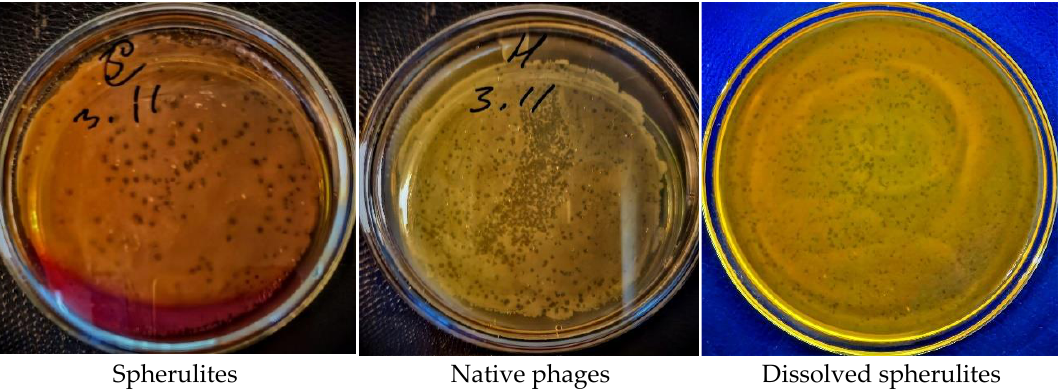
Figure 9. Influence of bacteriophages immobilized in CaCO 3 cores on the activity of phages.